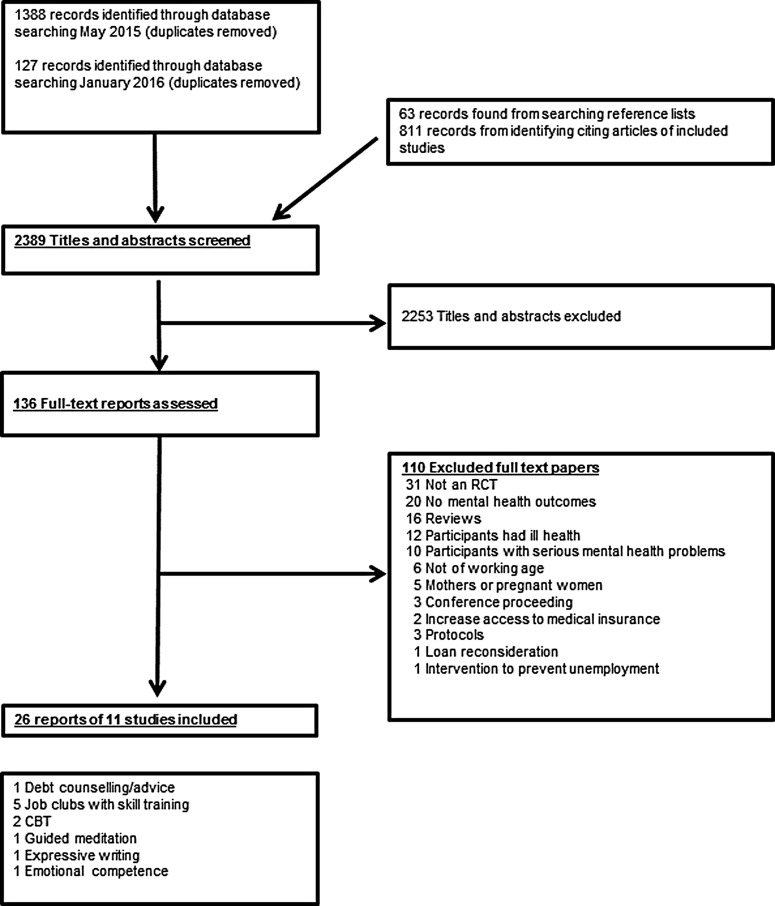
Study selection.